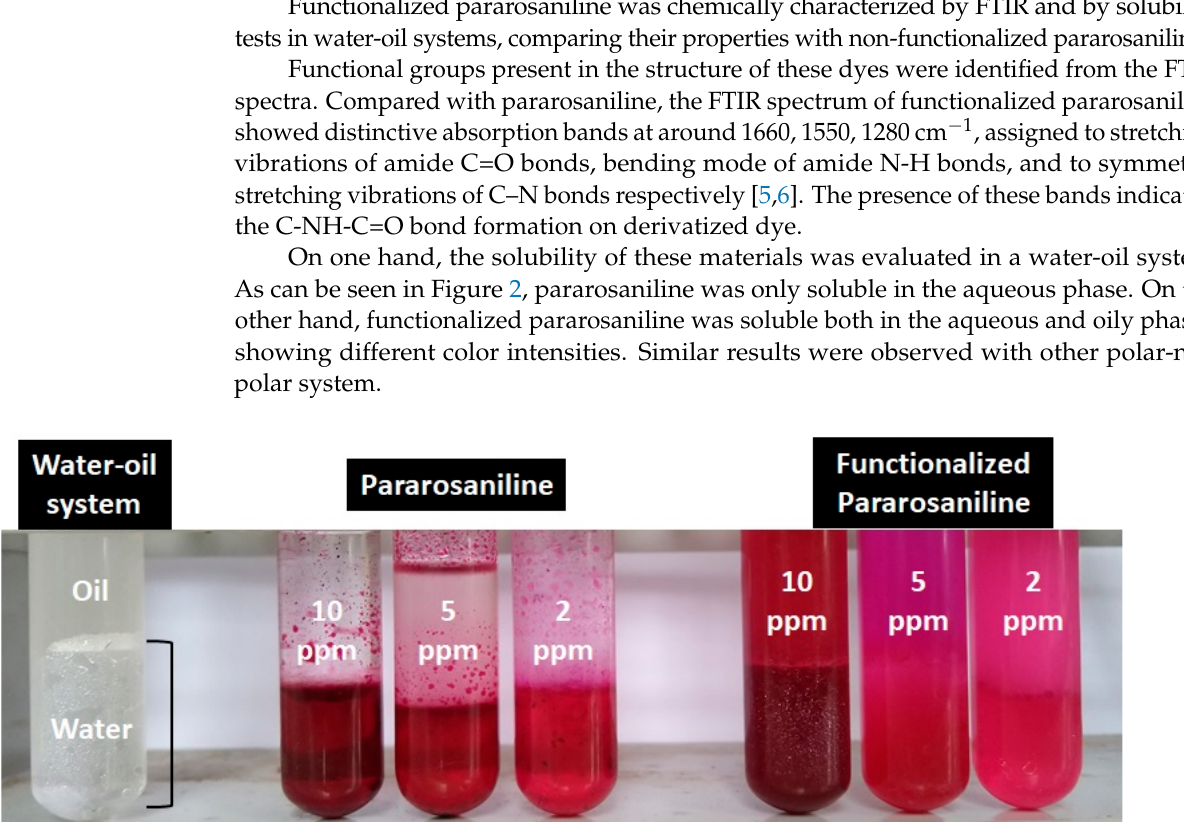
Figure 2. Picture of pararosaniline and functionalized pararosaniline dissolved in a water-oil system at different concentrations.